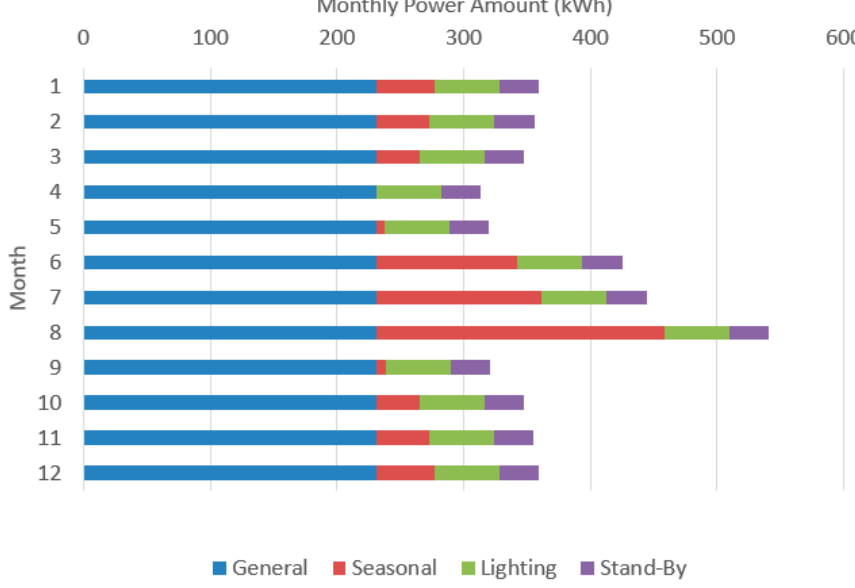
Figure 2. Monthly power consumption for a typical Korean house.